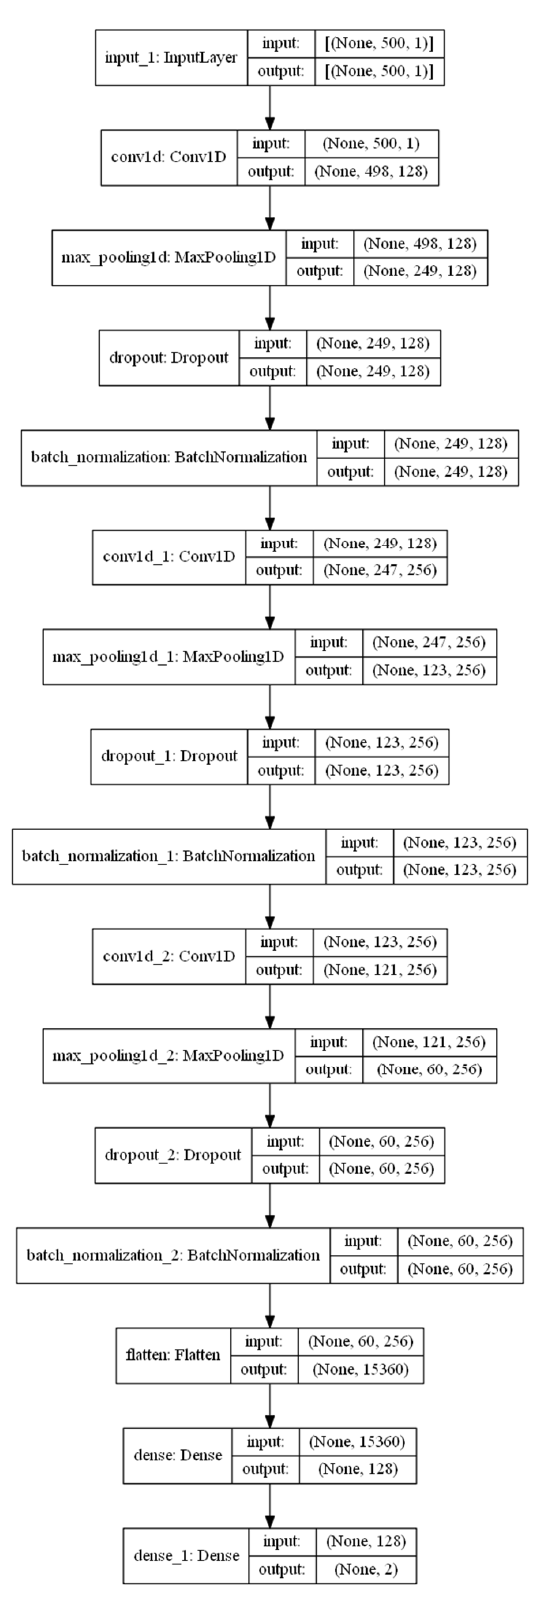
Figure 3. Architecture of the proposed 1D CNN model.